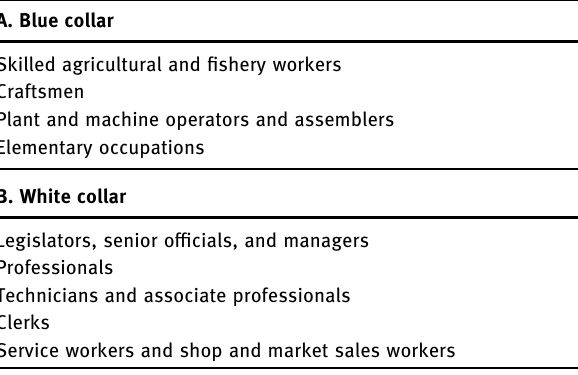
Table A1: Blue collar – white collar classi fi cation